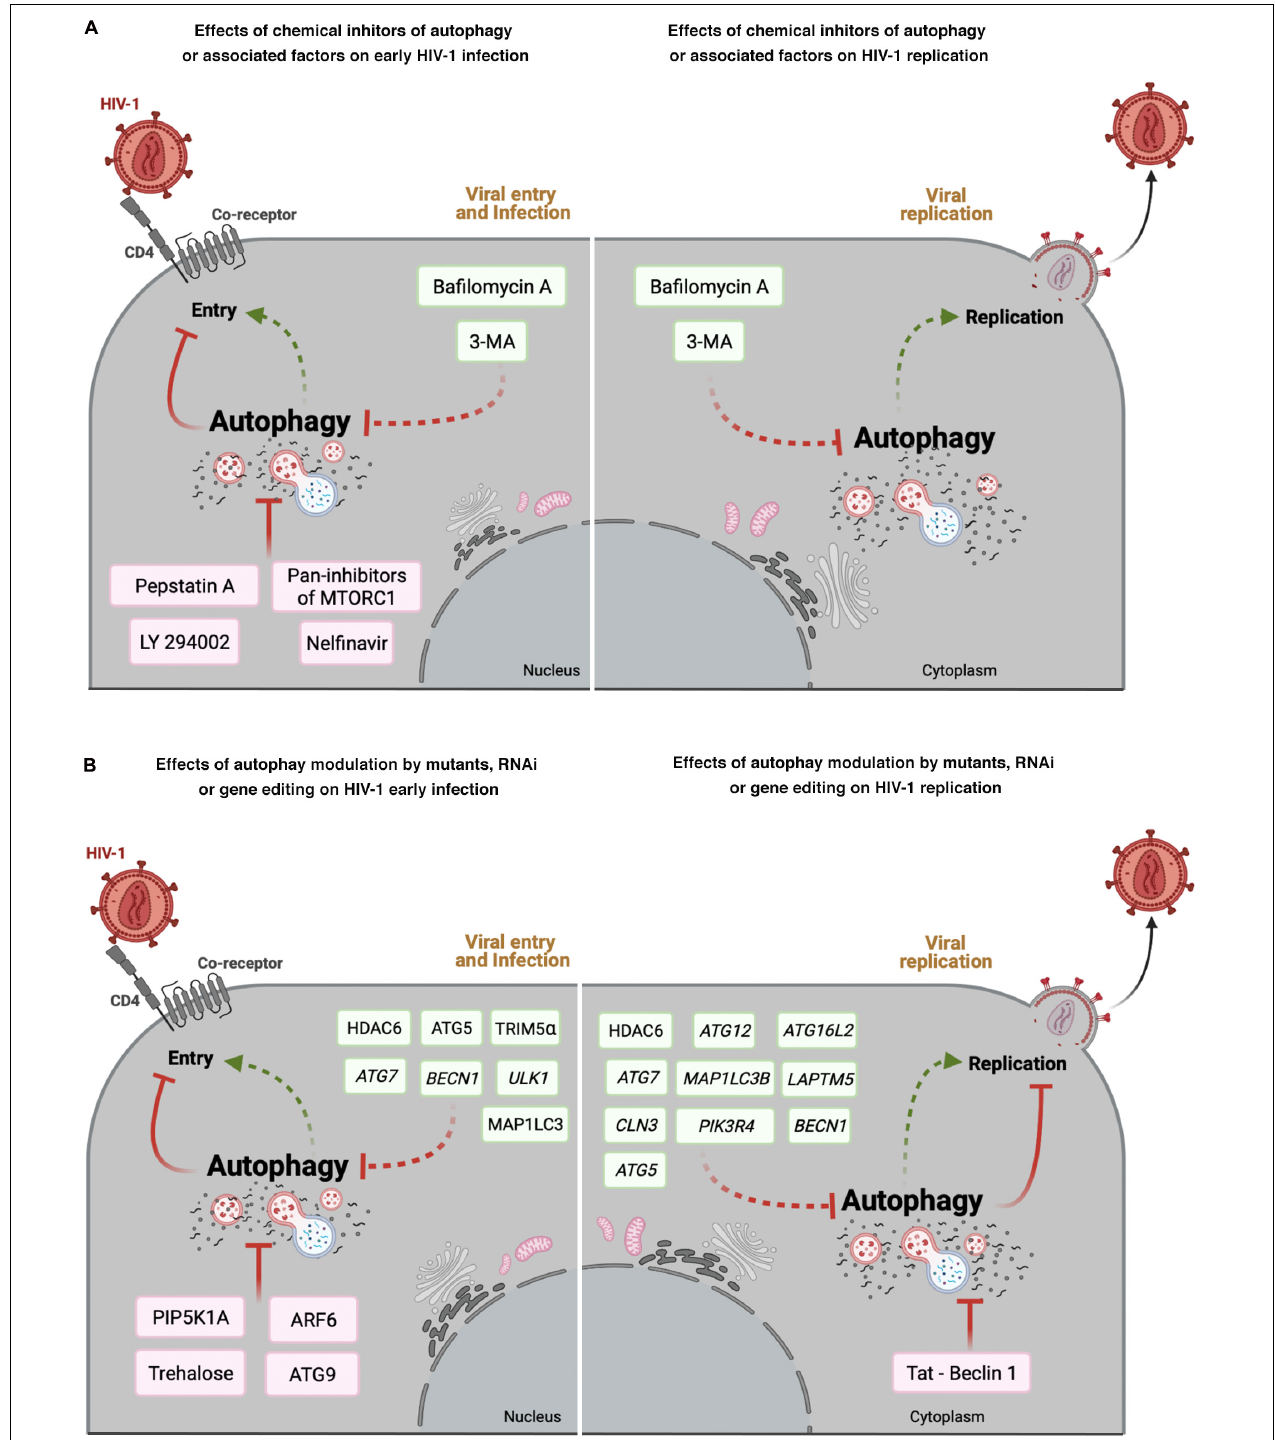
FIGURE 2 | Effect of autophagy modulation on HIV-1 infection. Cell scheme summarizing the autophagy modulatory effect on HIV-1 viral life cycle (early steps: viral entry and infection; late steps: viral replication). (A) This panel shows that chemical inhibitors of autophagy and associated factors could activate (factors indicated in green boxes) or prevent (factors indicated in pink boxes) early HIV- 1 infection (left) , or promote viral replication (right) . (B) This panel shows the effect of mutants of autophagy associated factors, or specific RNAi or CRISPR/Cas editing acting on autophagy-associated genes in HIV-1 early infection or viral replication. Autophagic factors that activate HIV-1 infection or replication are indicated in green boxes, whereas factors inhibiting HIV-1 are indicated in pink boxes. Arrow colors represent the reported positive (green) and negative (red) effects on the different steps of the viral life cycle, with dotted arrows signaling the HIV-1 activation pathway. This figure supports the information summarized in Table 2 . Cell schemes were created with